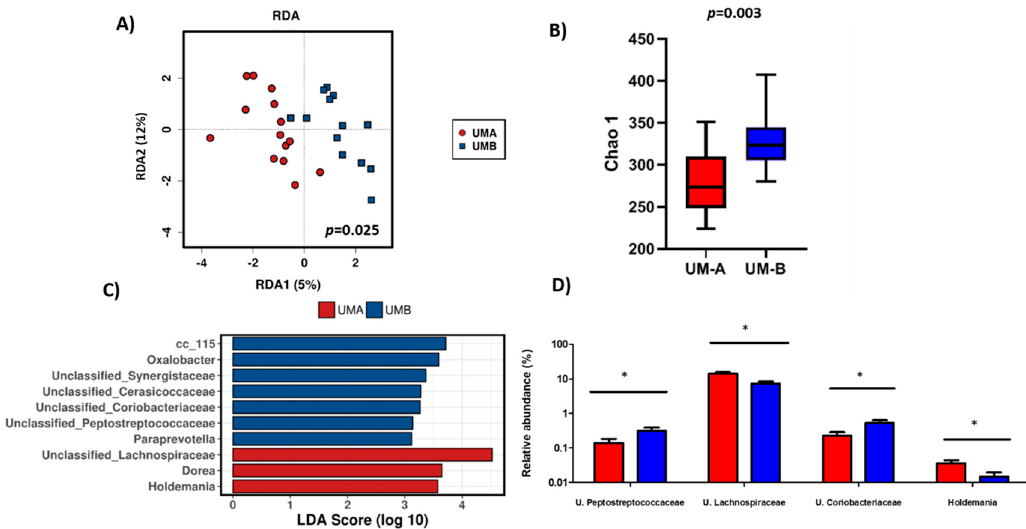
Figure 1. Gut microbiota composition and diversity according to metabotypes (UM-A and UM-B) before the intervention (T0). ( A ) Redundancy analysis (RDA) on the genus level. ( B ) Gut microbial richness was measured by Chao index. ( C ) Linear discriminant analysis (LDA) effect size (LEfSe) plot of taxonomic biomarkers identified in the gut microbiome of volunteers. ( D ) Relative abundances on genus level in UM-A and UM-B. ANOVA test was used to test significance differences in the relative abundances according to metabotype. Results are presented as mean ± SD. Significant differences ( p < 0.05) are marked with an asterisk (*).